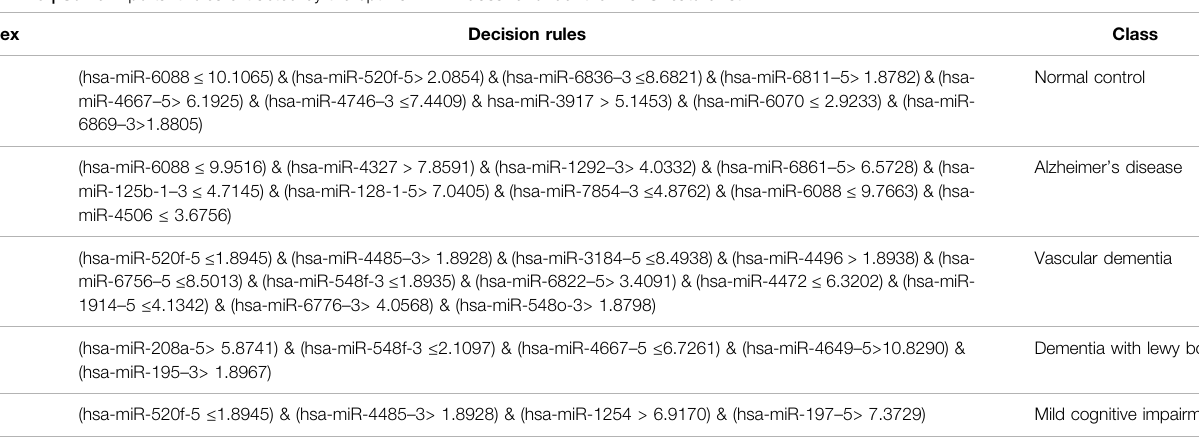
TABLE 5 | Some important rules extracted by the optimal PART classi fi er under the MCFS feature